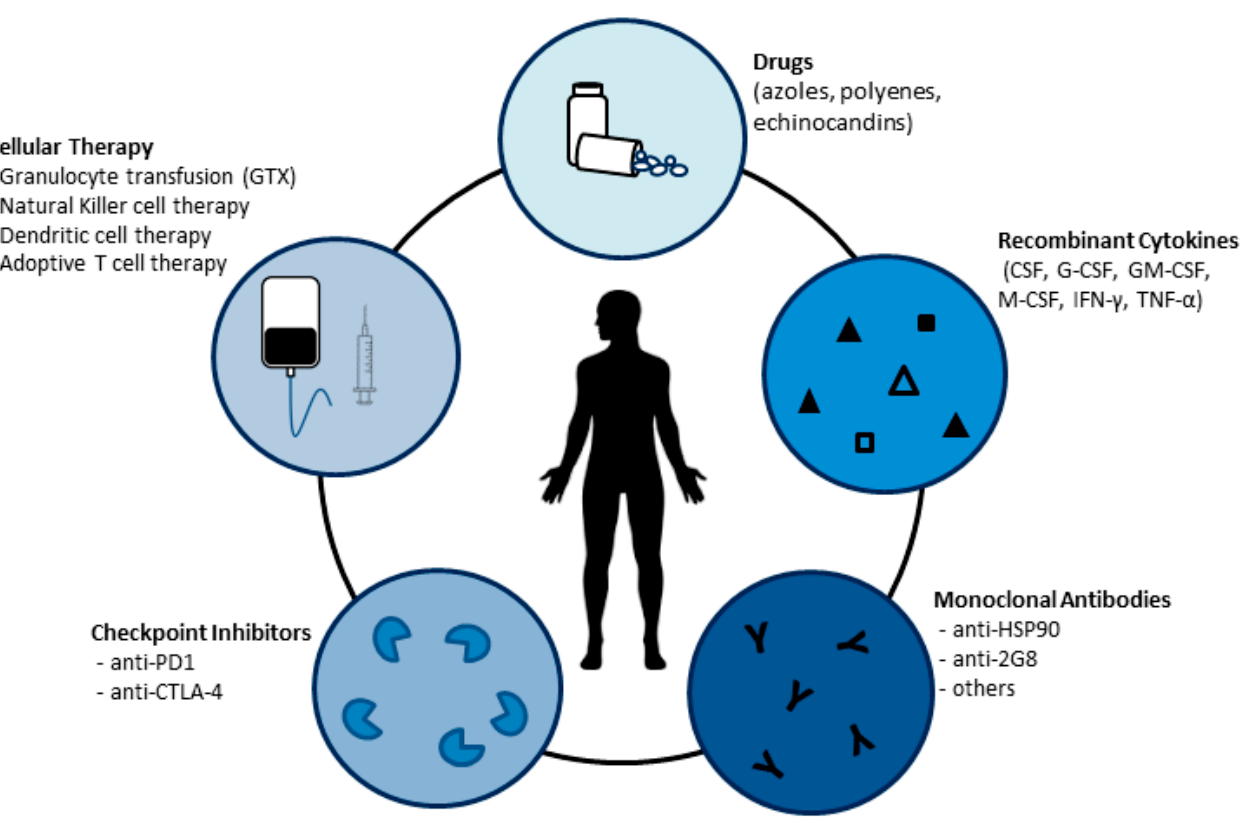
Figure 1. Standard and alternative therapeutic approaches for the management of invasive fungal infections.